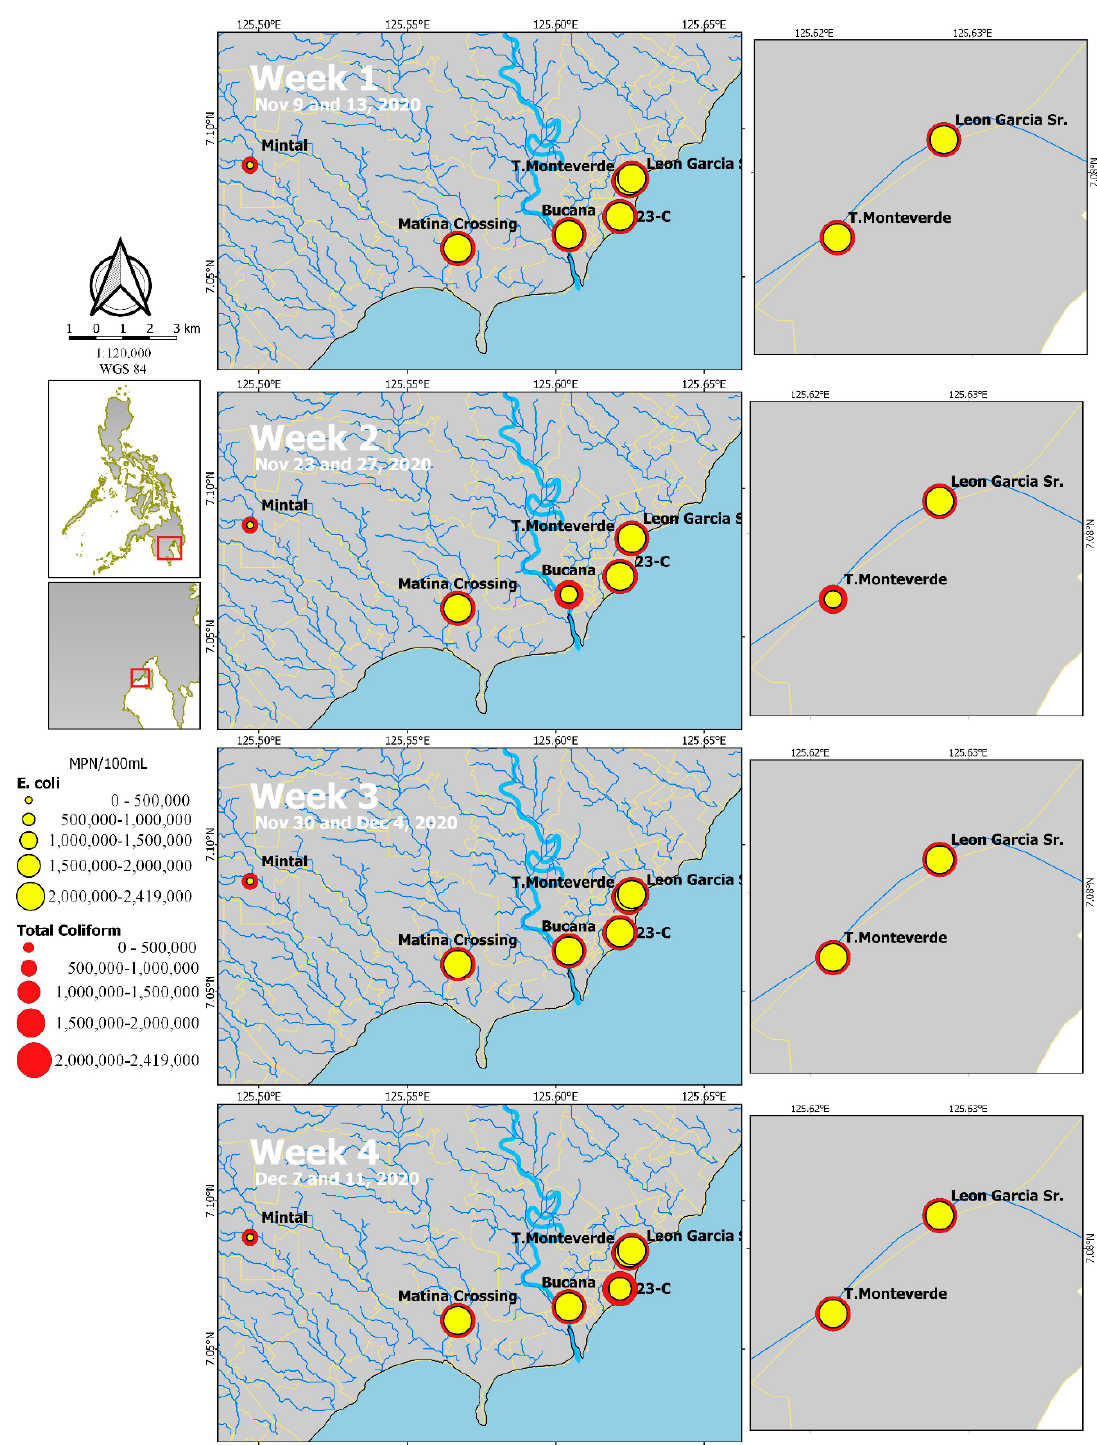
Figure 3. Total coliform and Escherichia coli ( E. coli ) quantification in Most Probable Number (MPN) using the IDEXX method for the sampling sites indicated.